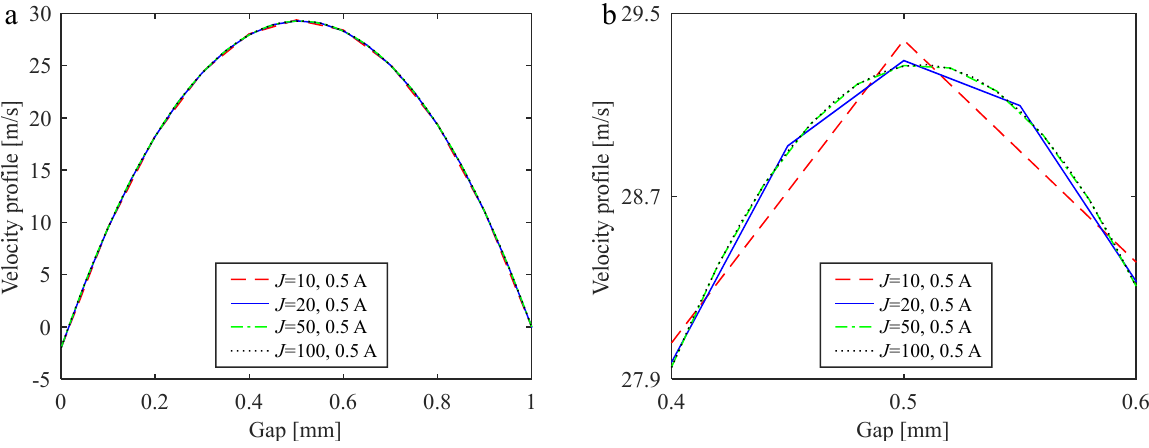
Figure 23. Velocity profiles and acceleration profiles at time 0 35 = . ms t and 0 6 = . ms t tivated region for the excitation current of 2 A.